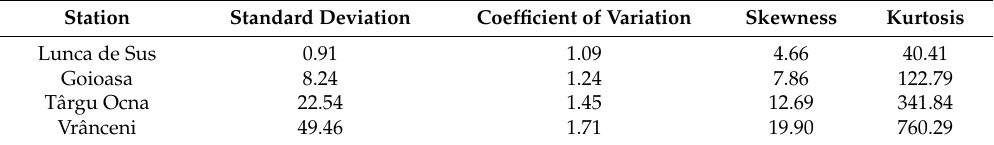
Figure 2. Comparisons between histograms and kernel density approximations of discharge data for the Trotu ș River. ( a ) Goioasa; ( b ) Târgu Ocna. Table 2. Basic statistics of daily flow time series (1994–2014) from Trotu ș River.